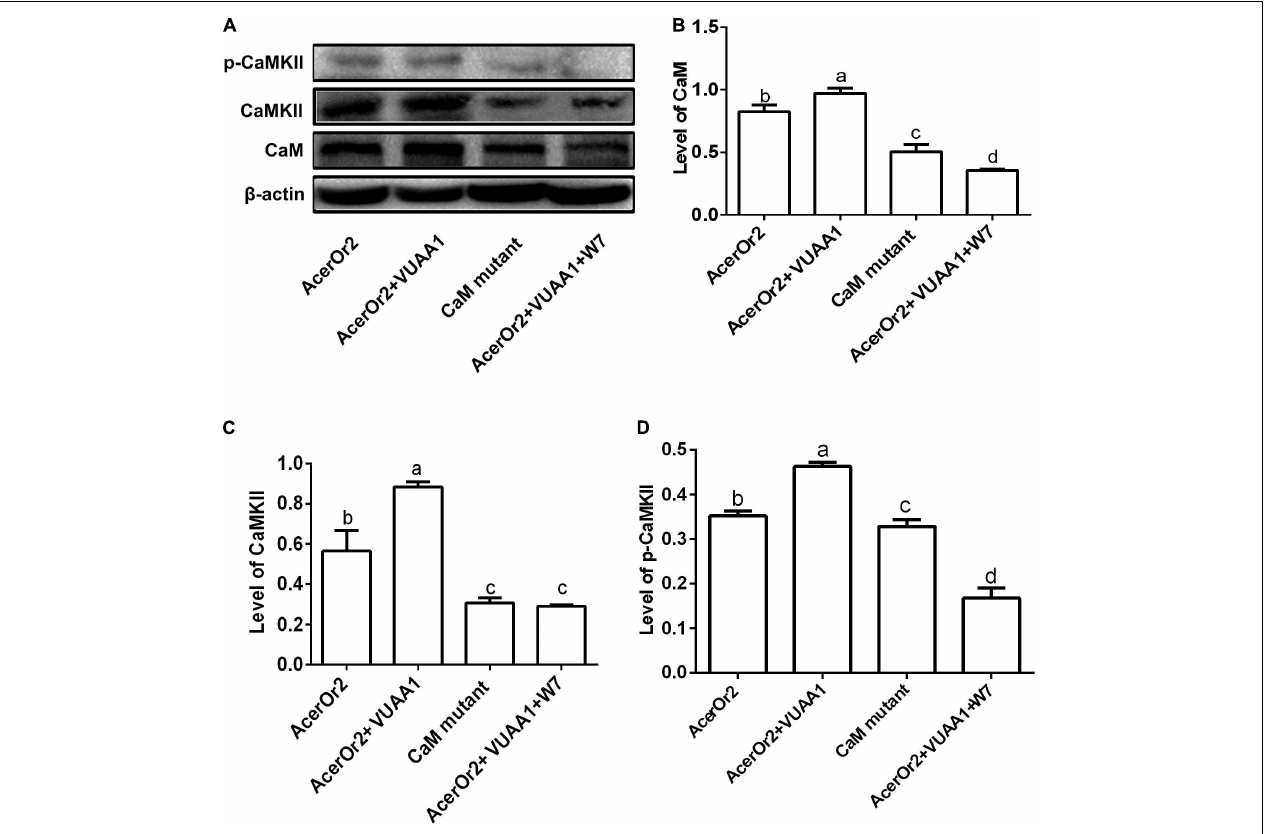
FIGURE 4 | Effects of the VUAA1 agonist on CaM, CaMKII, and p-CaMKII protein expression in Sf9 cells transfected with the AcerOr2 and its CaM-binding mutant (K331N) constructs in the absence/presence of the CaM inhibitor W7, and the expression levels of CaM, CaMKII, and p-CaMKII in these cells were assessed by Western blot analysis at 12 h. (A) Western blot showing the expression of p-CaMKII, CaMKII, CaM, and β -actin. The molecular weight of p-CaMKII, CaMKII, CaM, and β -actin has molecular weights of 54, 72.7, or 56.3, 16.7, and 43 kDa, respectively. (B–D) Expression of CaM, CaMKII, and p-CaMKII relative to that of β -actin. Bars represent the mean ± SEM from 3 independent experiments, and data were analyzed using one-way ANOVA. Different letters indicate the significant difference among groups ( P <